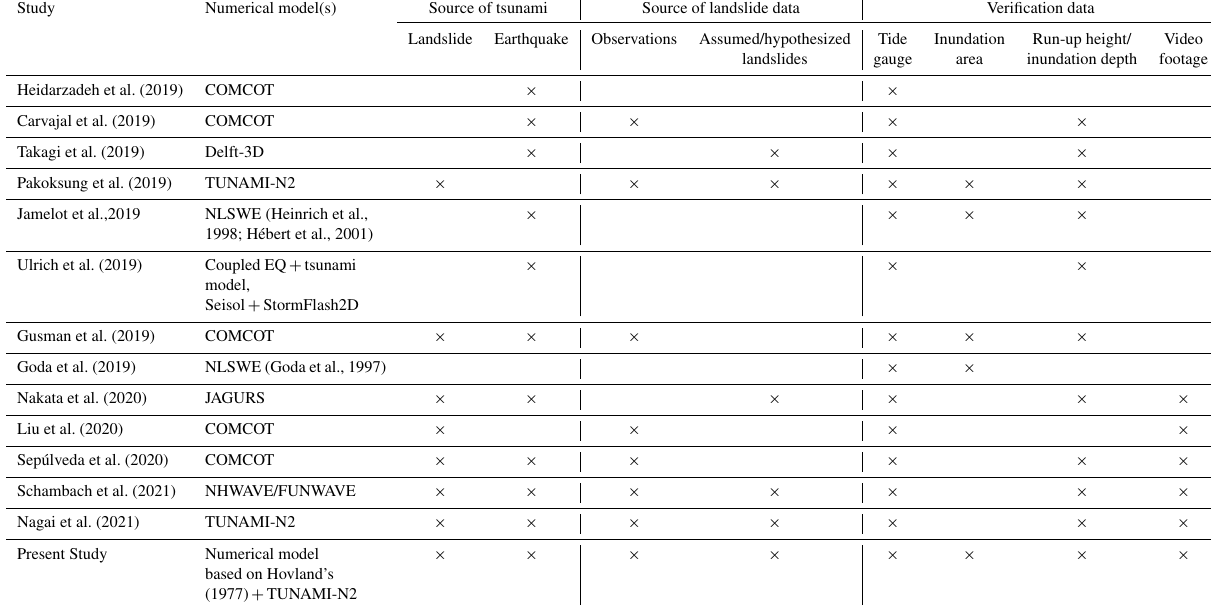
Table 1. Summary of the main characteristics of the 2018 Palu event and tsunami reported in previous